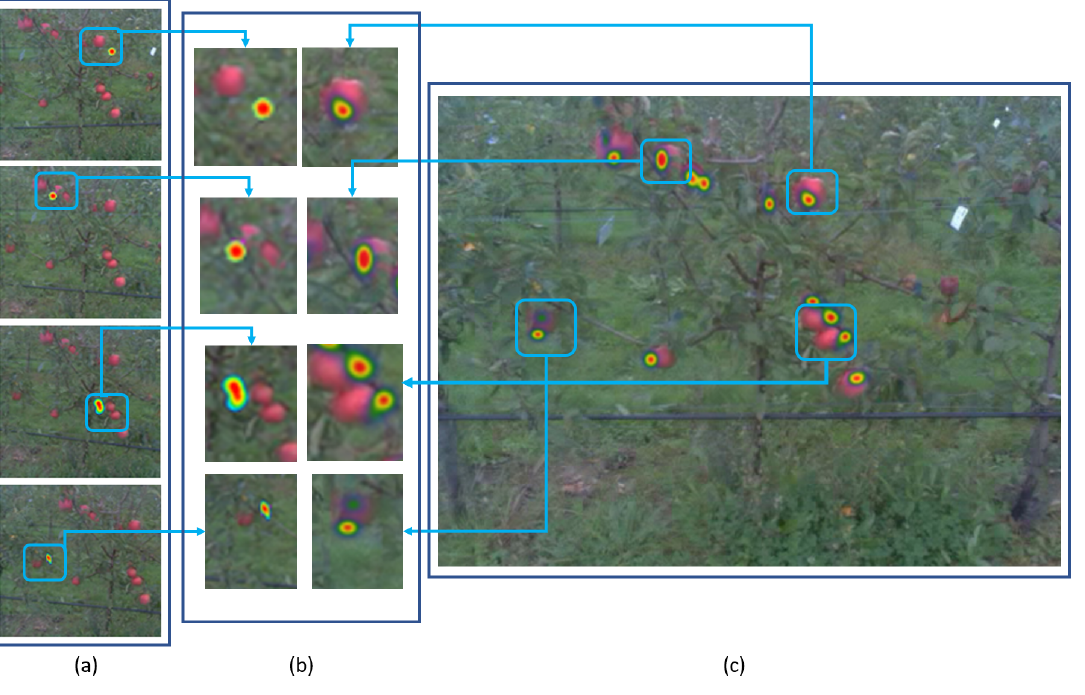
Figure 7. Heatmap visualization of the attention of the viewer captured by the head-mounted (glasses) eye-tracker ( a ) versus the screen-based eye-tracker ( c ). ( b ) Comparison of the heatmap generated by the glasses eye-tracker (left) vs. the heatmap generated by the screen-based eye-tracker